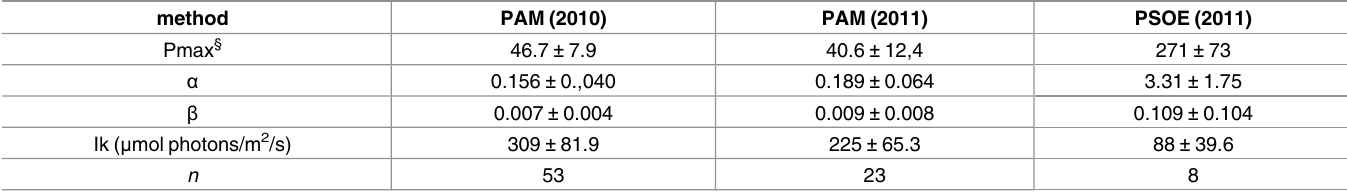
Table 4. Parameters of photosynthesis / irradiance